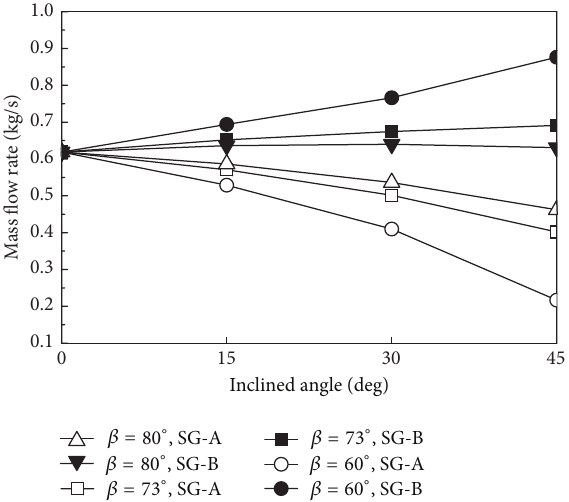
Figure 12: Effect of flow resistance distribution (experimental